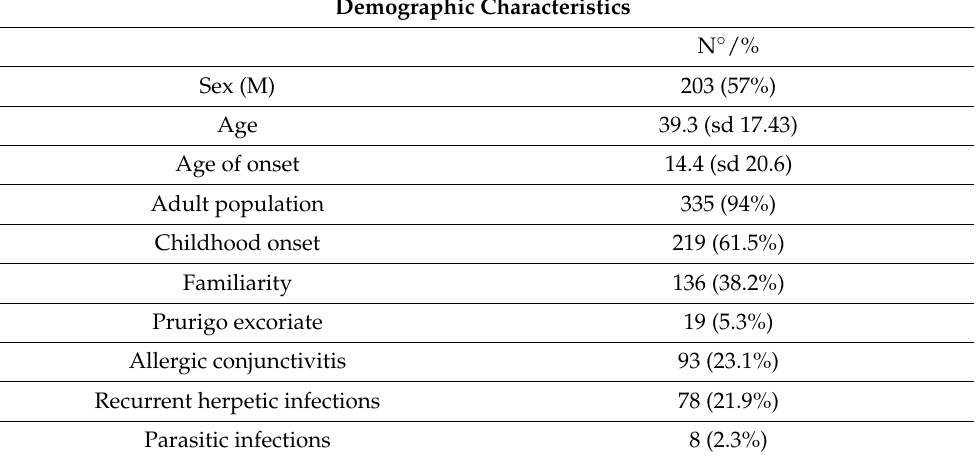
Table 1. Demographic characteristics.